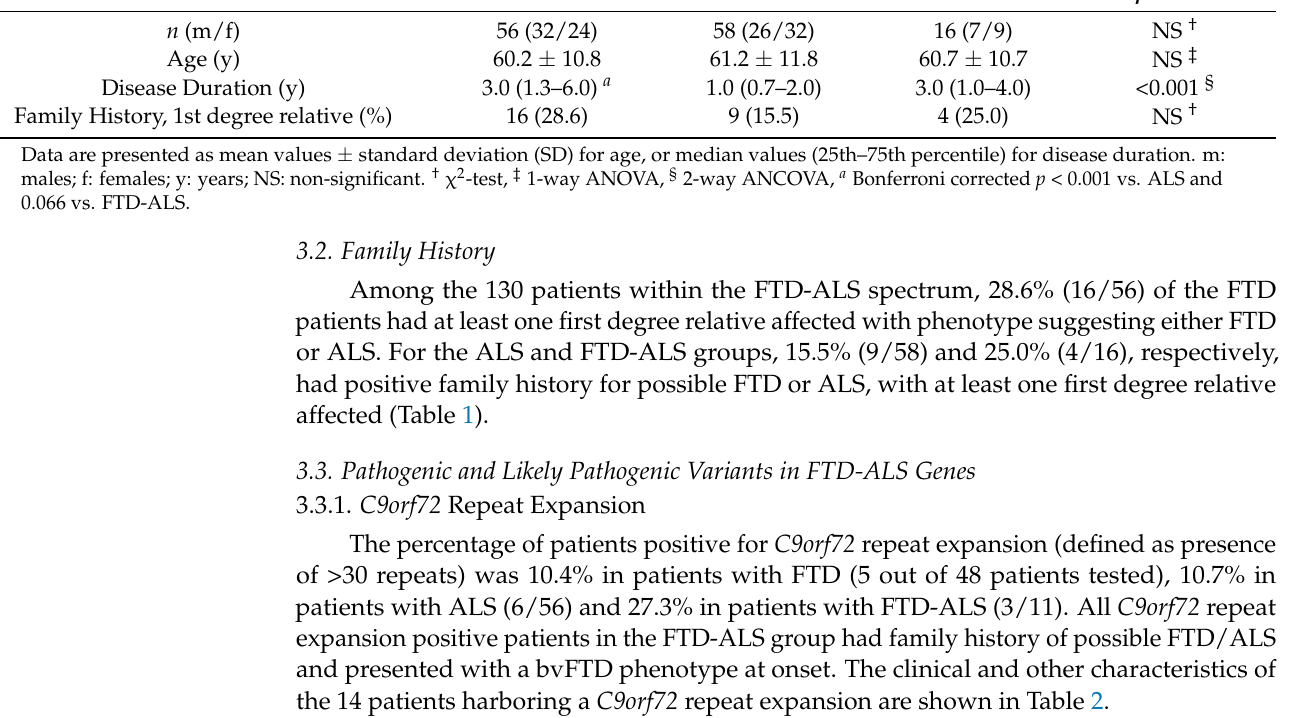
Table 1. Demographic and clinical data of the studied groups. FTD ALS FTD-ALS p